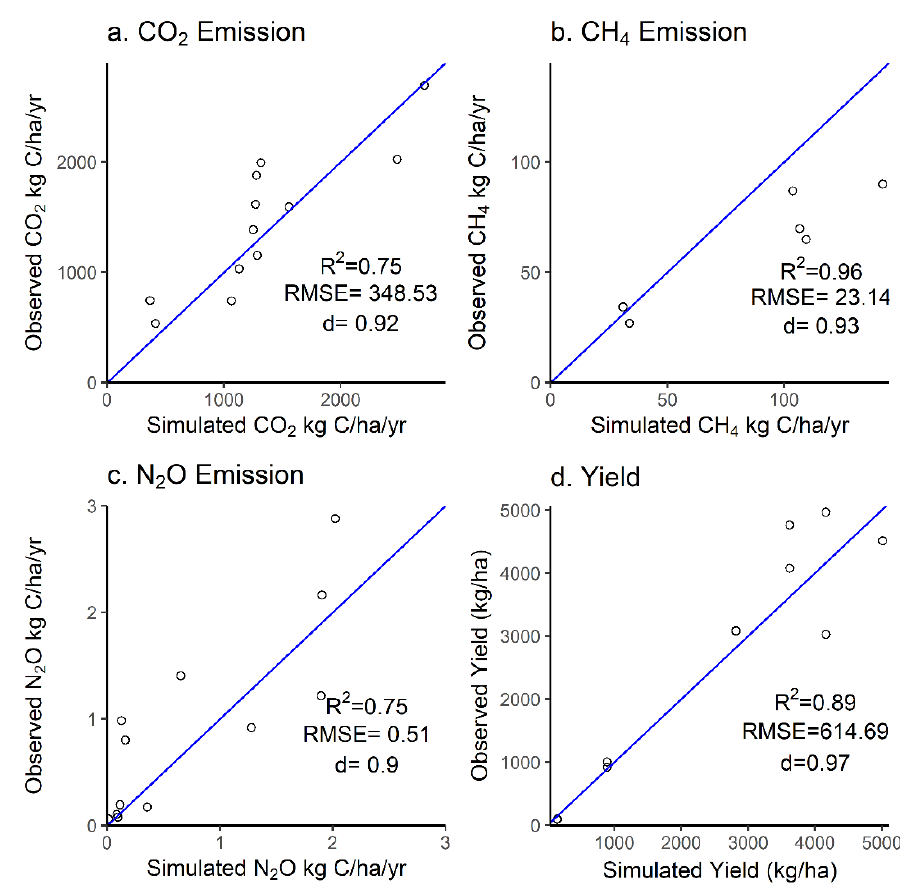
Figure 5. Observed and simulated seasonal ( a ) CO 2 , ( b ) CH 4 , and ( c ) N 2 O emissions and ( d ) crop yields under the different cropping systems and fertilizations from 2012 to 2014.